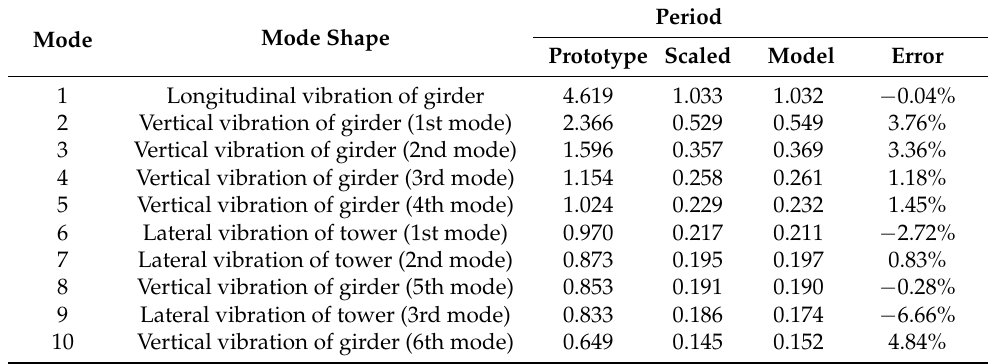
Table 3. Comparison of natural periods.